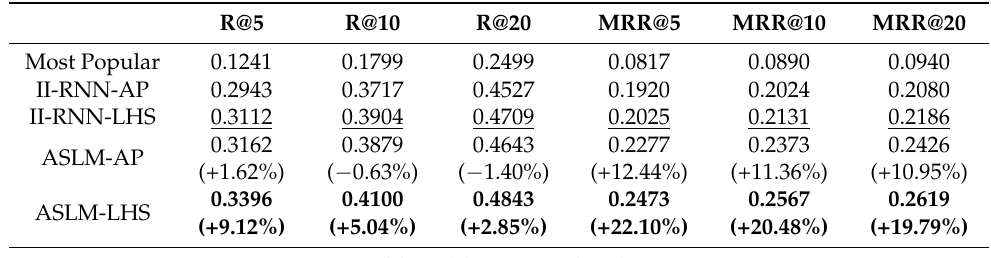
Table 1. Group A: Recall and MRR scores for the ASLM models and the baselines for the test sets in Reddit and Last.fm